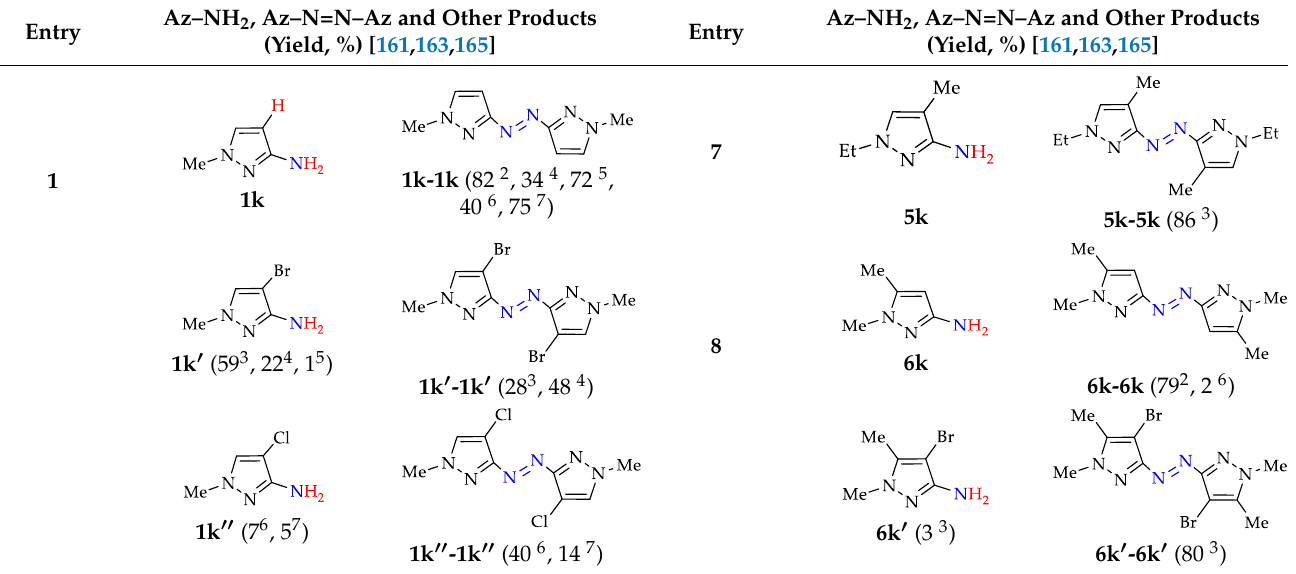
Table 6. N – N homo-coupling of aminopyrazoles (Az – NH 2 ) using approaches A, B, C (C ’ ), D (D ’ ) 1 .